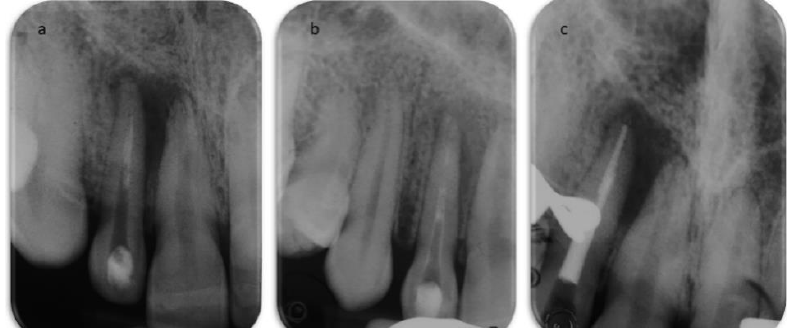
Figure 4. Root canal treatment. ( a ) Periapical radiograph after the first access to the root canal system. ( b ) Radiograph showing the calcium hydroxide temporary dressing within the canal after the first visit. ( c ) Periapical radiograph after obturation of the root canal system.